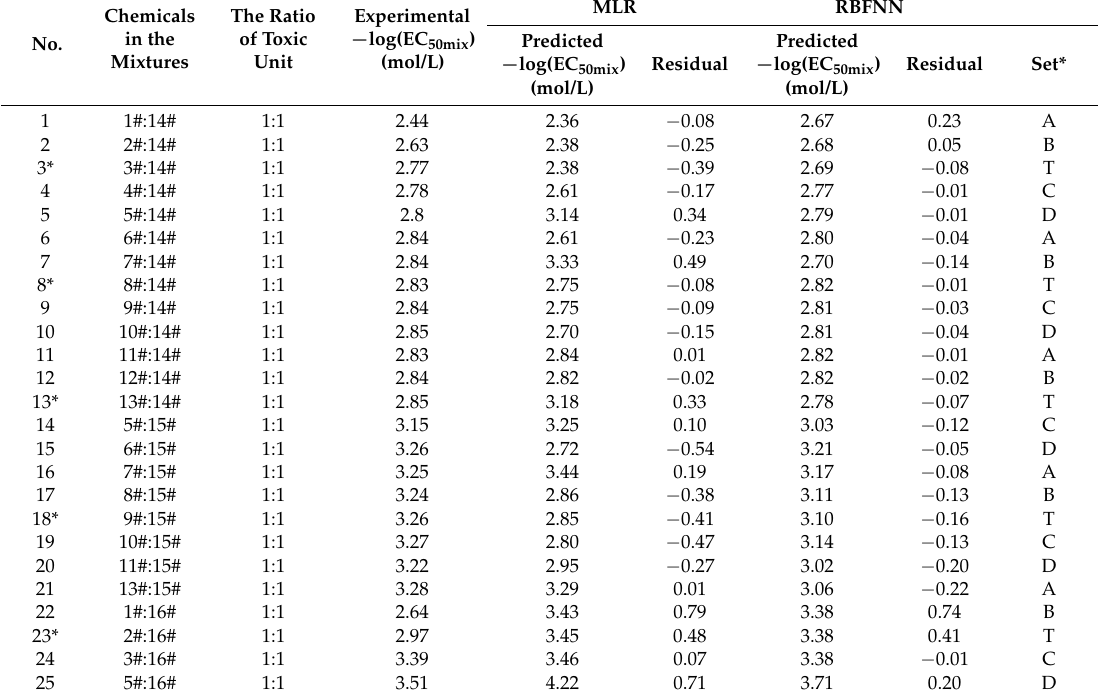
Table 5. The No., chemicals in the mixtures, ratio of toxic unit, experimental − log(EC 50mix ), predicted − log(EC 50mix ), and their corresponding